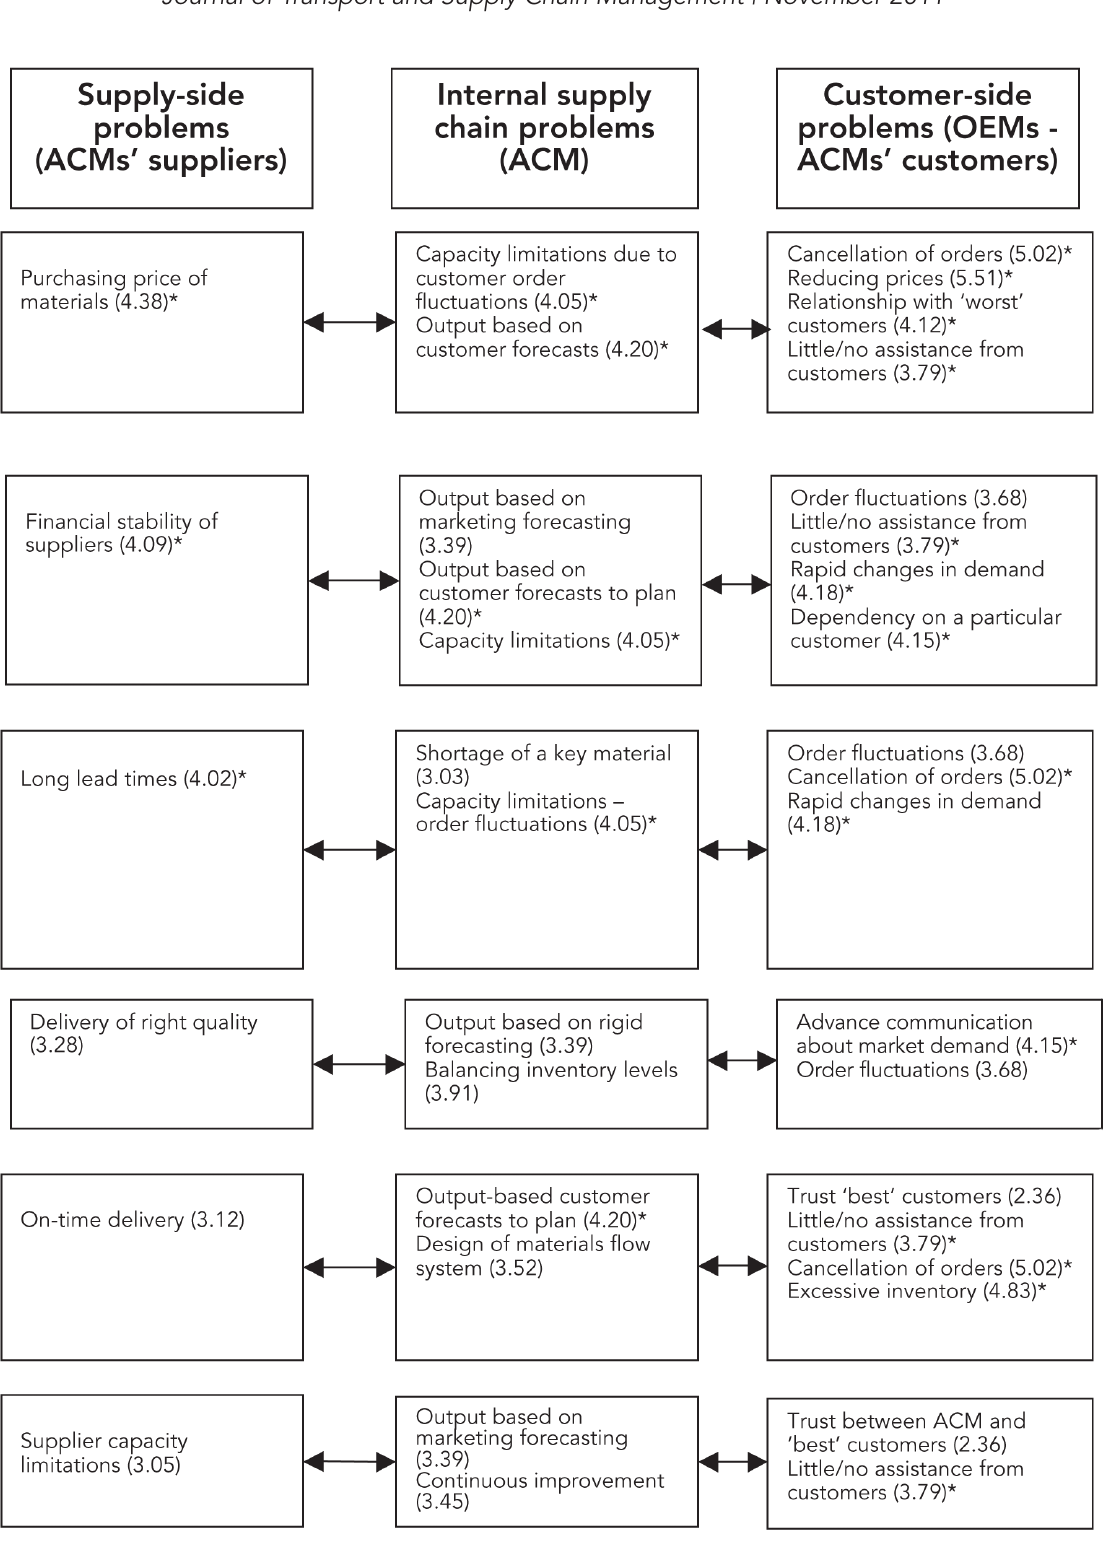
2 Figure 2 indicates that items on the supply side (ACMs’ suppliers) correlate with problems in internal process and customer-side